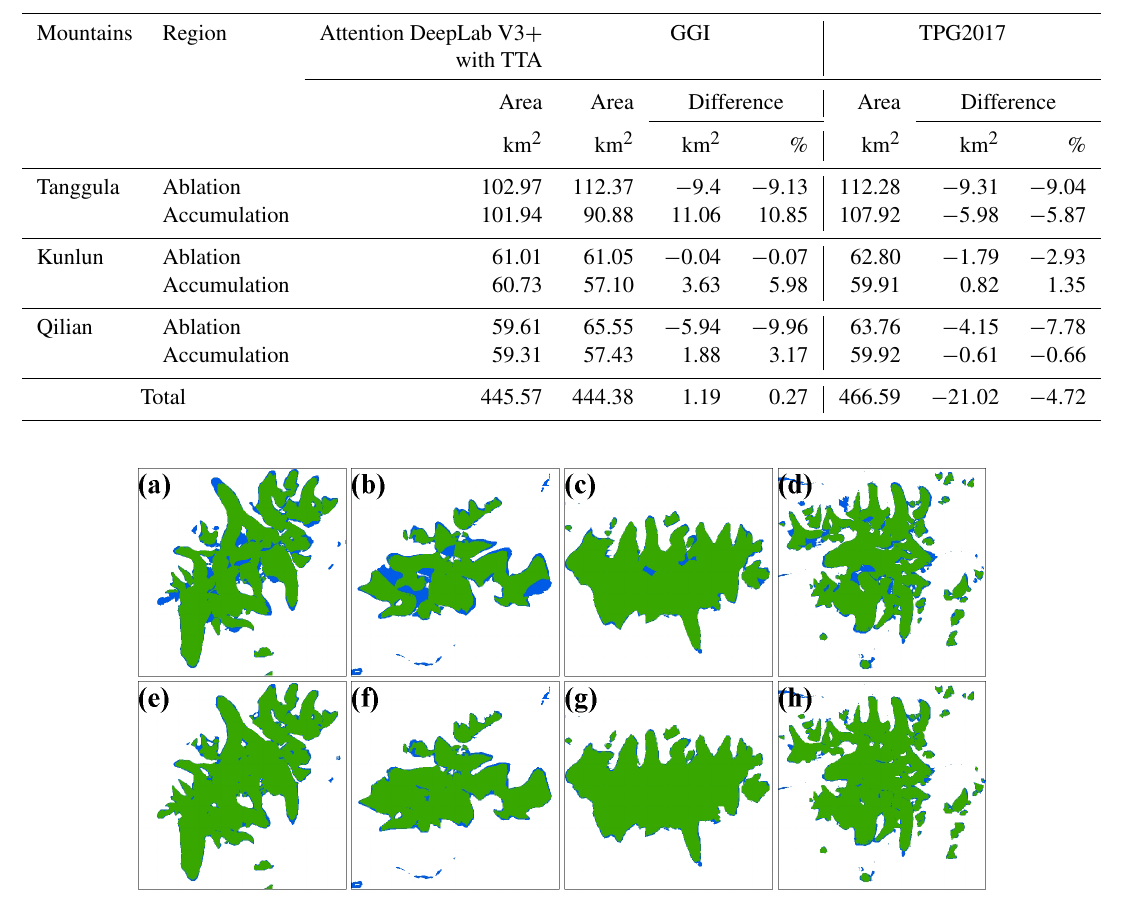
Figure 20. Panels (a) – (d) are the comparison between our results and the GAMDAM glacier inventory, and (e) – (h) are the comparison between our results and the TPG2017. Green and blue colors are the same and different areas in the two datasets,